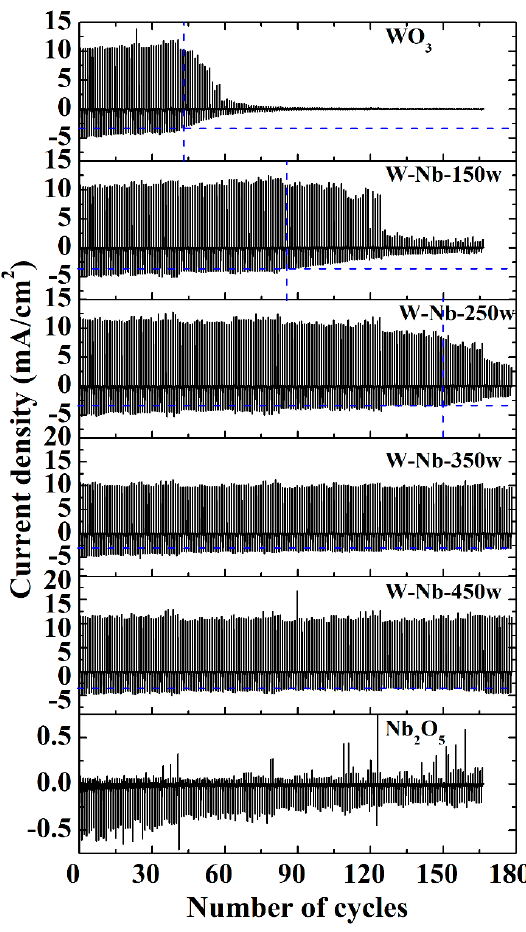
Figure 10. Chronoamperometry for WO 3 , WO 3 –Nb 2 O 5 , and Nb 2 O 5 films.